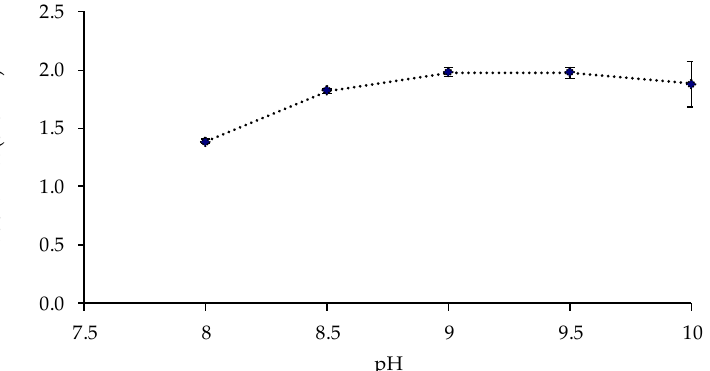
Figure 4. Effect of the pH value of the ammonium chloride/ammonia buffer solution on the sensor response (1 mg L − 1 Cd(II); 0.225 mol L − 1 buffer; n = 2).